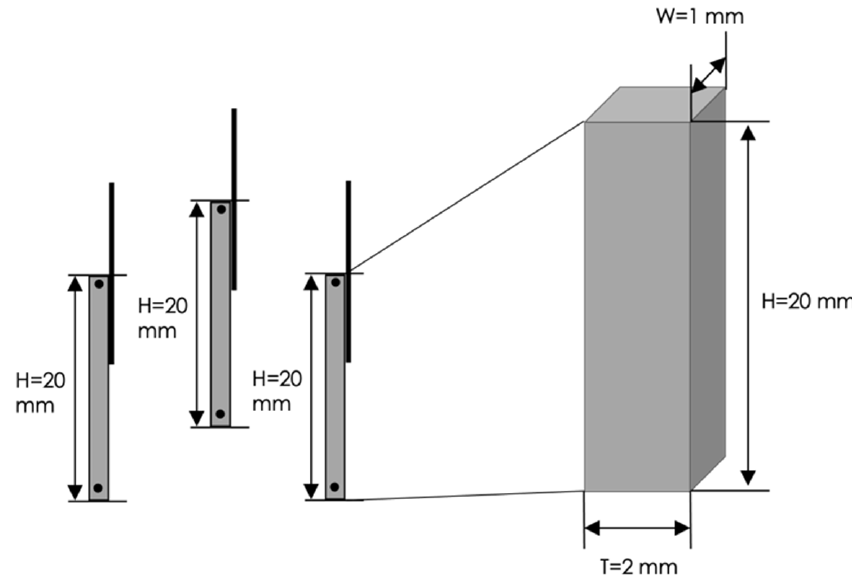
Figure 4. Geometric dimensions of the three electrodes embedded in the Prototype 2. These electrodes, which we called “bar” electrodes, were positioned onto the BHV stent along leaflet centerlines (Figure 5).